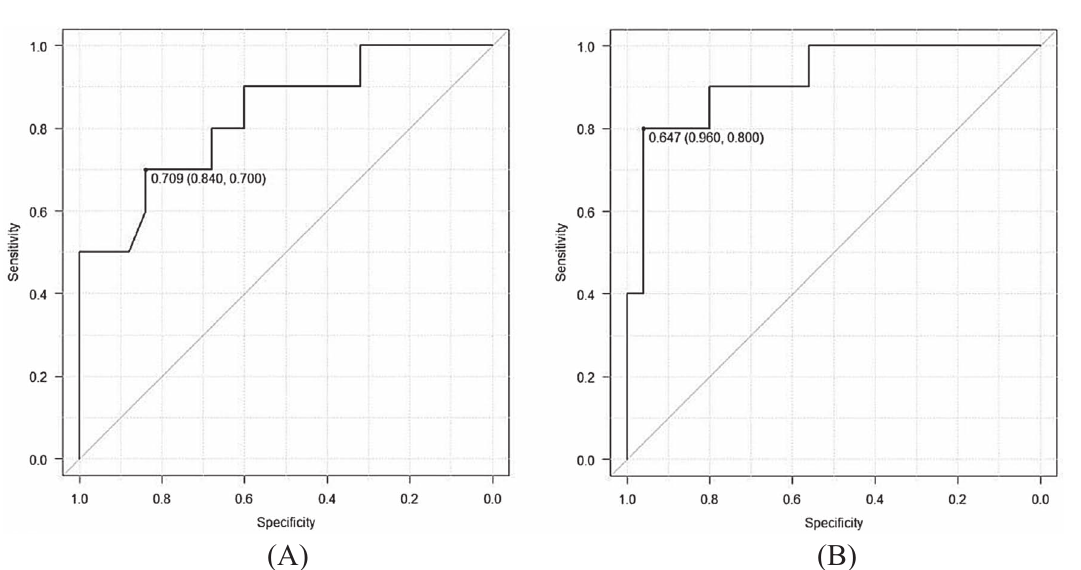
Figure 3. ROC curve of the transverse coverage rate of the VLF. Sensitivity and speci fi city were 84% and 70%, respectively (3A). ROC curve of the longitudinal coverage rate of the VLF. Sensitivity and speci fi city were 96% and 80%, respectively